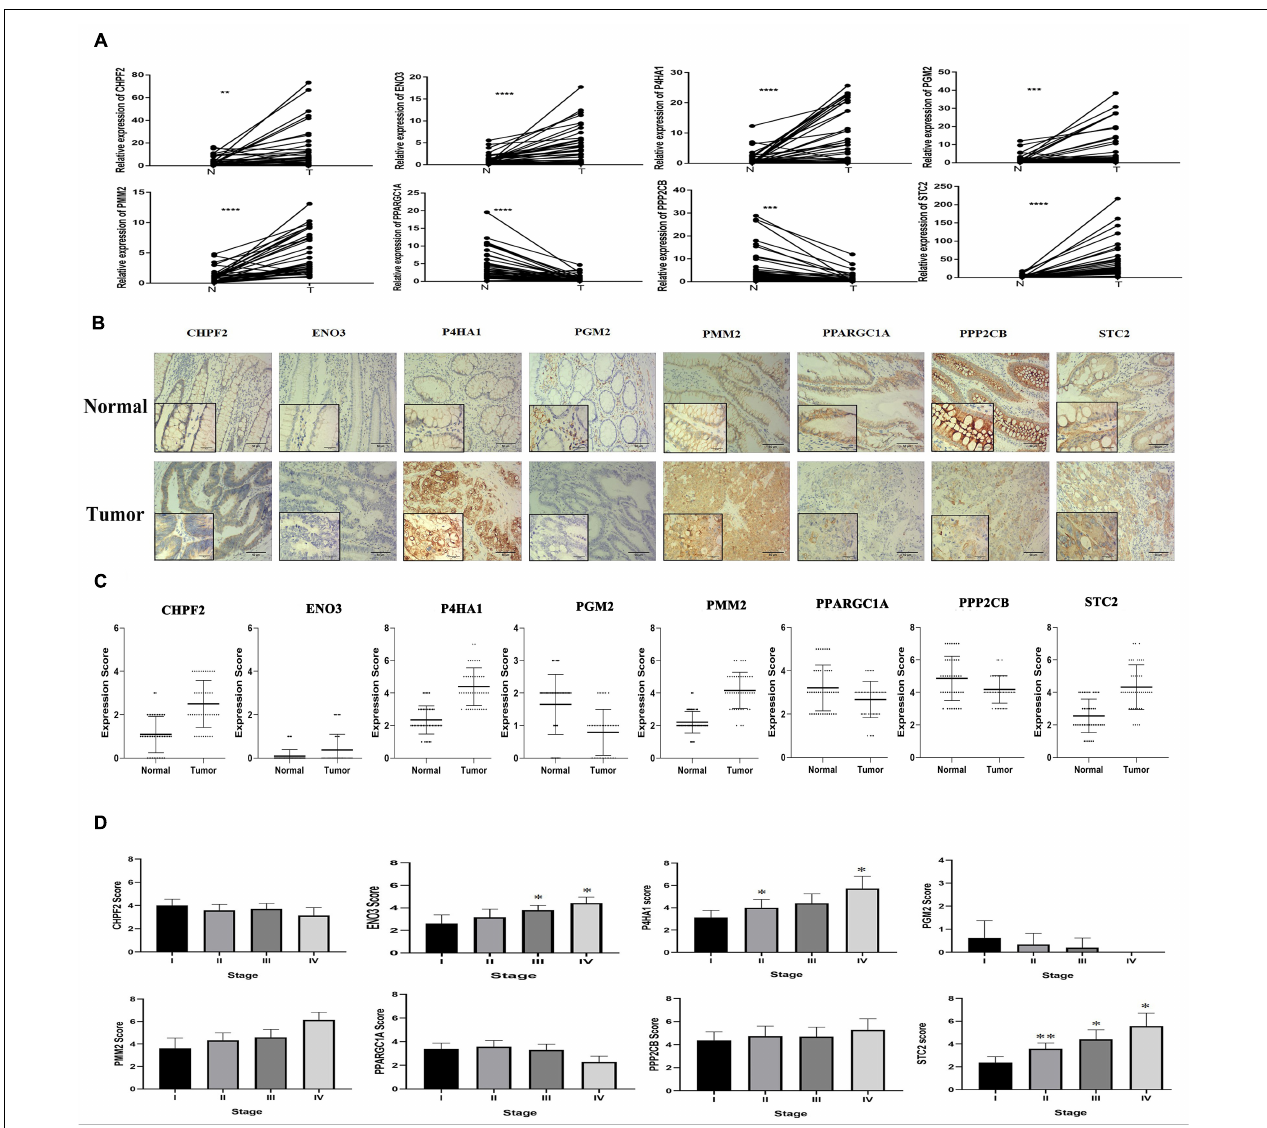
FIGURE 10 | Eight glycolysis-related gene GRG expression in clinical samples. (A) mRNA expression of eight GRGs in clinical samples. (B) Protein expression analysis of eight GRGs in tumor and normal samples using immunohistochemistry analysis. Scale bar represents × 100, × 400, or 100 µ m. (C) Eight GRG protein scores in tumor and normal samples. (D) GRG protein expression at the distinct stage of tumor. One-way analysis of variance used for statistical analysis, * p < 0.05, ** p < 0.01 versus stage I. All data are expressed as mean ±